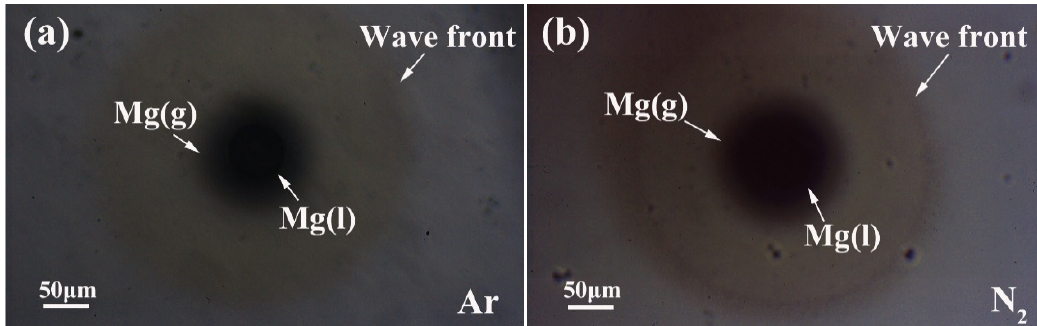
Figure 6. Pictures of the shock wave effect on the cracking of the porous magnesium oxide film, ( a ) in Ar; ( b ) in N 2 . The propagation displacement of shock wave is shown in Figure 7. Despite in Ar or in N 2 , the shock wave propagated exponentially, and the propagation displacement can be expressed as: where D s is the propagation displacement of the front of the shock wave, and t is the propagation time. D 0 , a, and k are the coefficients.